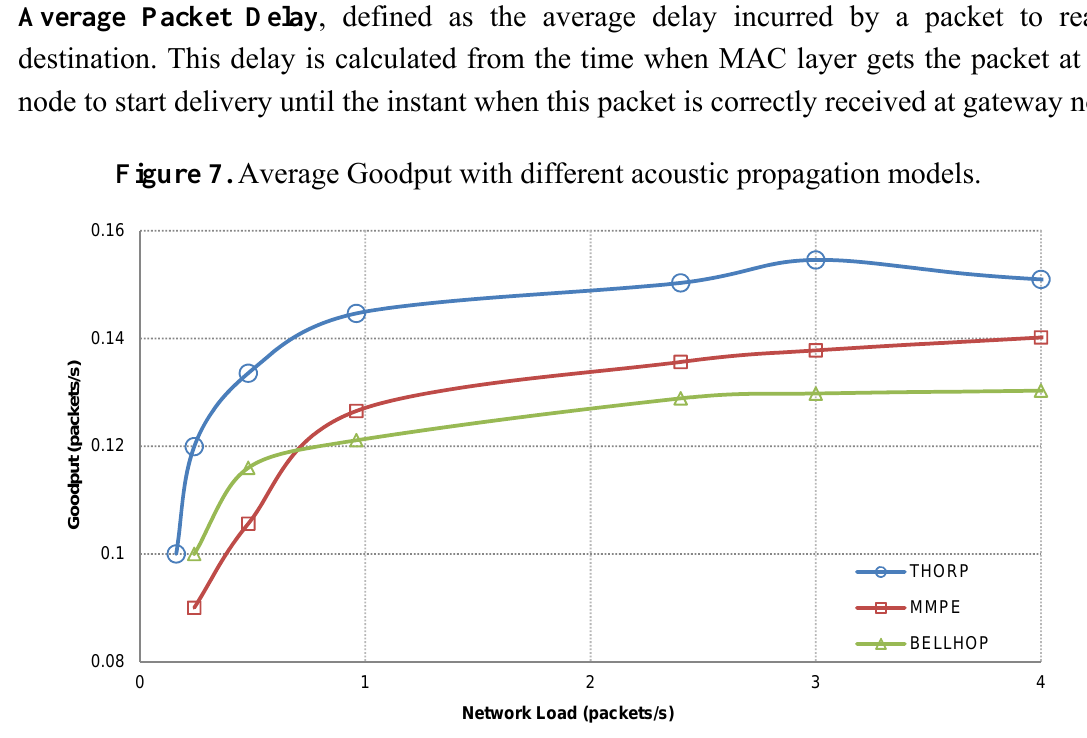
Figure 8. Valencia’s (scenario location) annual average sound speed as a function of node